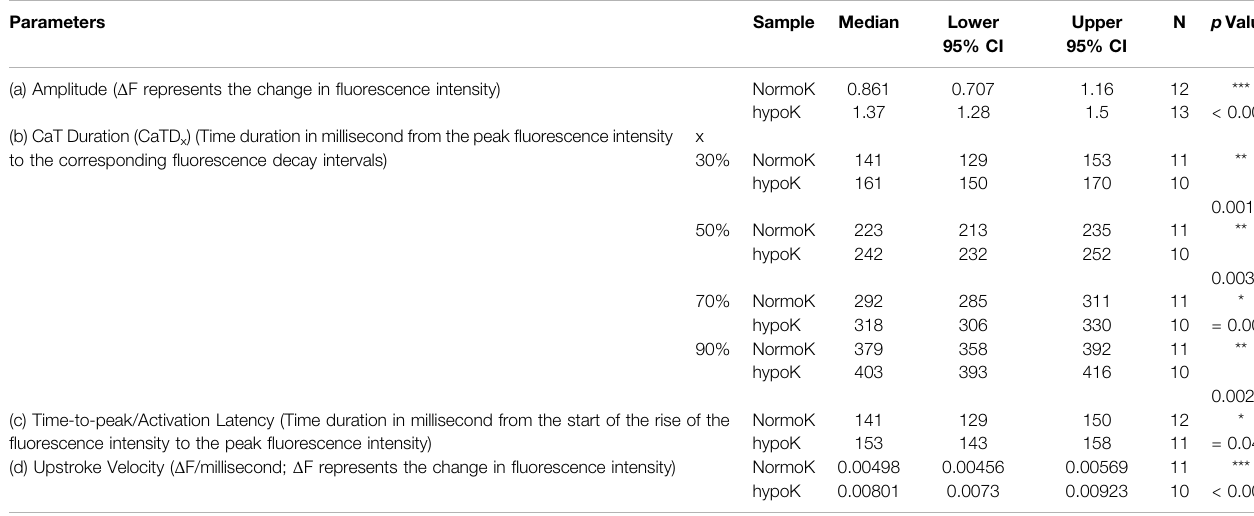
TABLE 2 | hES2-hvCAS Calcium Transient (CaT) Parameters in acute hypokalaemia. Data analysis was performed for 1.5 Hz electrical stimulation recordings. Parameters